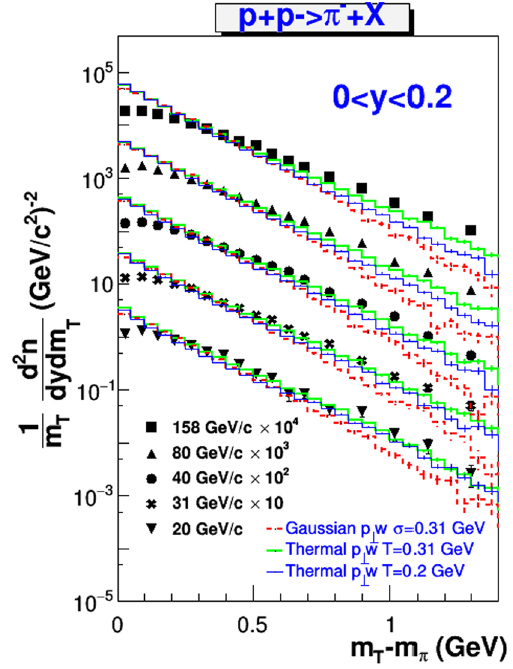
Fig. 2 SameasFig.1,butfortherapiditydistributions.Theopenpoints symmetrize NA61/SHINE data [9]